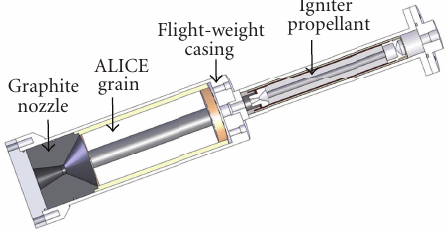
Figure 8: Schematic of the flight-weight motor casing.